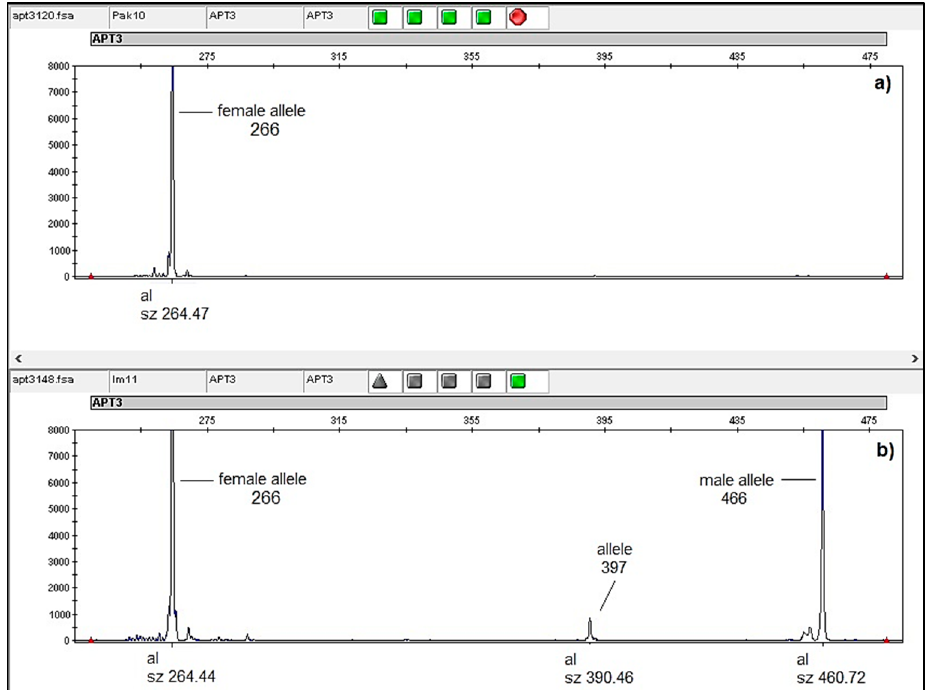
Figure 5. Screenshot of electropherogram (GeneMapper 6.0, Applied Biosystems, Waltham, MA, USA) displaying flower polymorphism at APT3 marker: ( a ) female individual Pak10, homozygous for allele 266 linked to female V. sylvestris [31], ( b ) male Im11 individual with the most frequent allelic pattern 266-397-466 at APT3 .